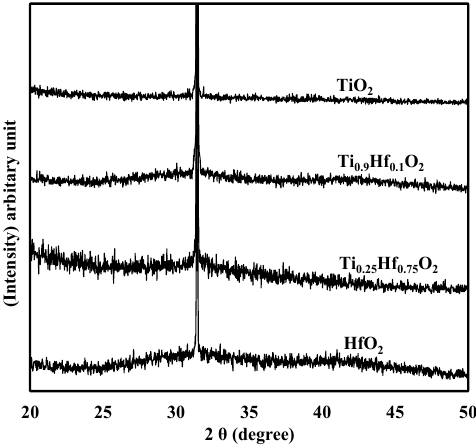
Figure 7. XRD patterns for the 10 nm HfO 2 , Ti 0.25 Hf 0.75 O 2 , Ti 0.9 Hf 0.1 O 2 , and TiO 2 thin films deposited on